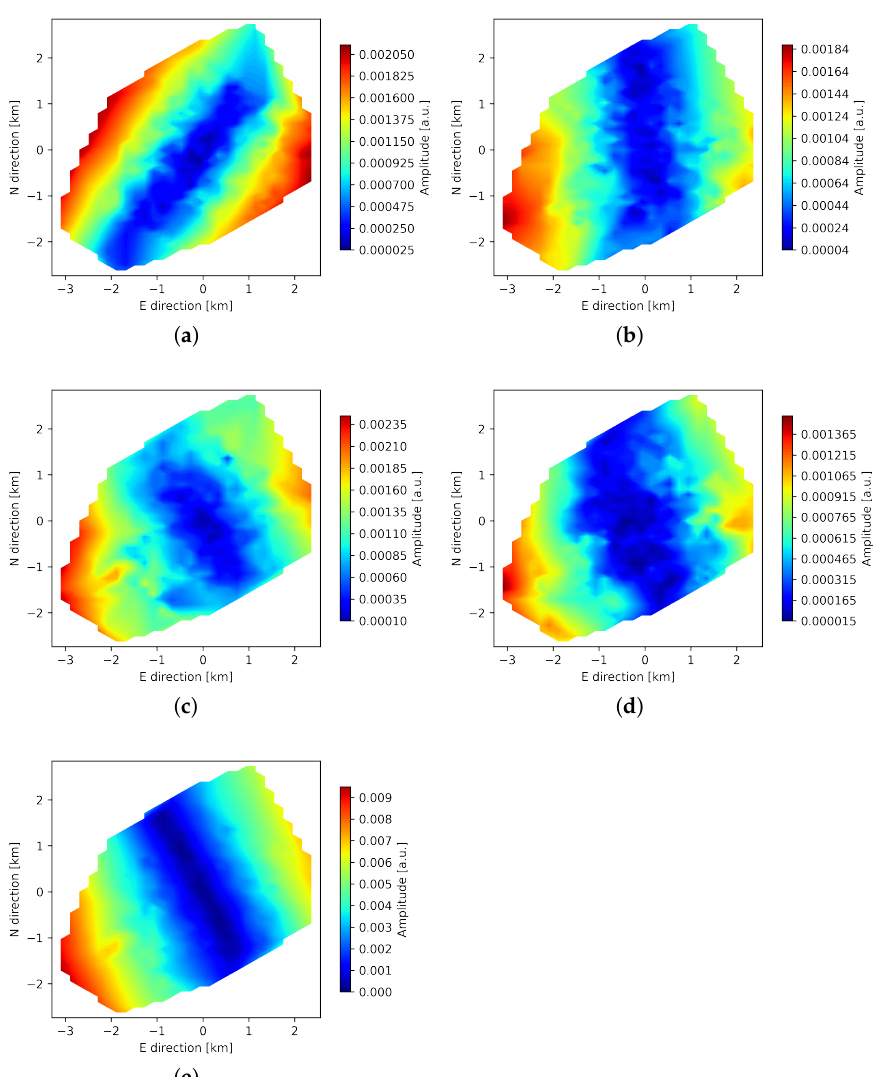
Figure 9. Amplitudes of core stations for observation L82655 for peaks 1–5 of L82655 peaks set (panels ( a – e )) at 4 min central period (see